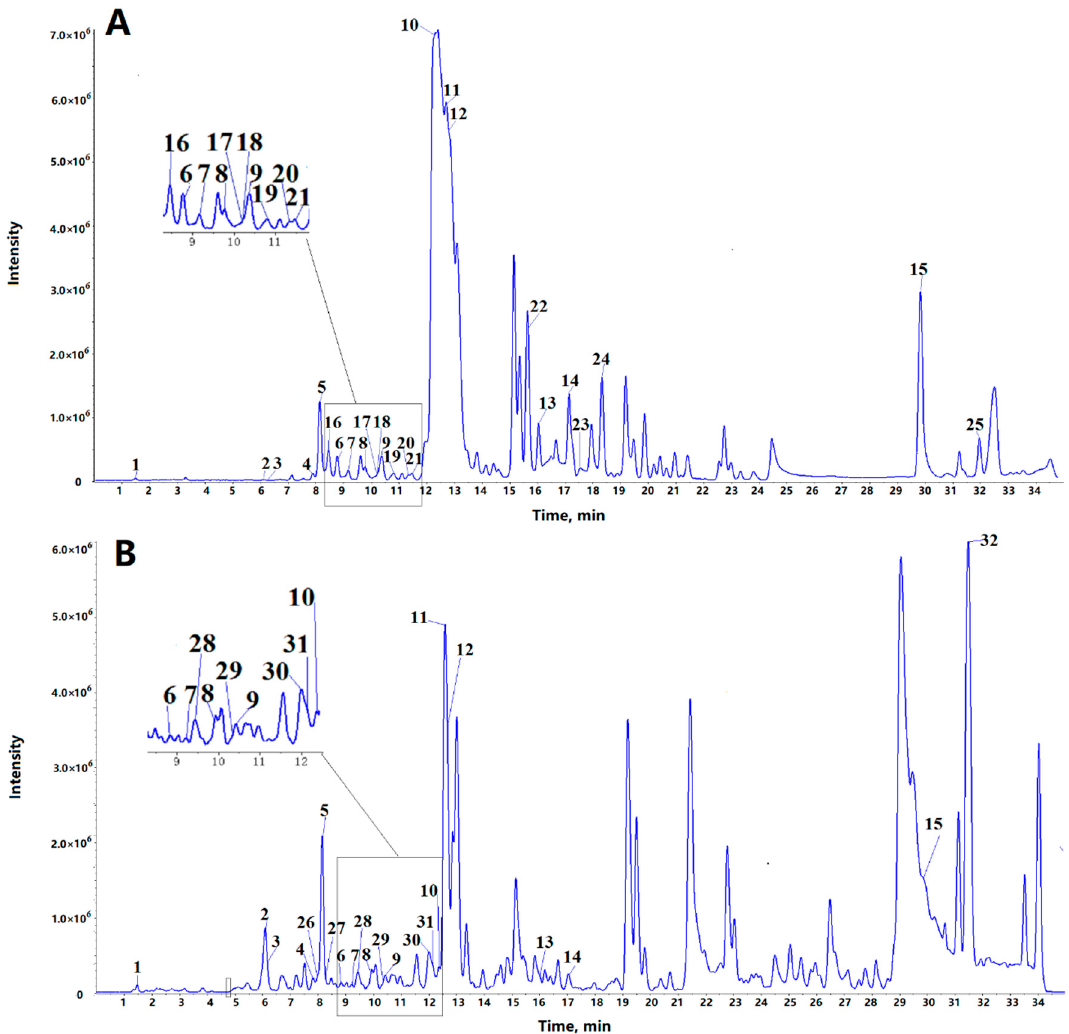
Figure 1. Total ion chromatogram of alkaloids from ABSP ( A ) and ABSSP ( B ) by LC-MS/MS. A total of 32 alkaloids were identified and the corresponding numbers listed in Table 1. ABSP: bamboo shoots of Pleioblastus amarus (Keng) Keng f.; ABSSP: bamboo shoot shells of P. amarus (Keng) Keng f.